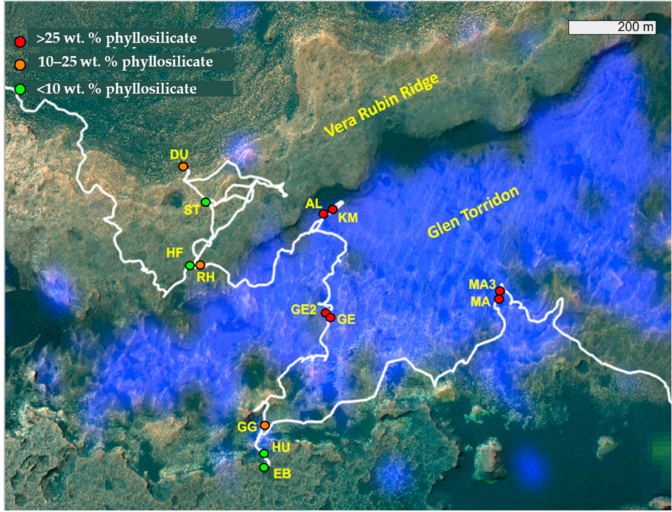
Figure 4. Compact Reconnaissance Imaging Spectrometer for Mars (CRISM) map of Fe/Mg–smectite spectral absorptions detections from orbit in the Glen Torridon region of Gale crater with the darkest blue representing the deepest spectral absorptions attributed to phyllosilicate (map courtesy Valerie Fox), and with drill holes reflecting CheMin phyllosilicate abundances. Red circles, phyllosilicate abundances greater than 25 wt. %. Orange circles, phyllosilicate abundances 10–25 wt. %. Green circles, represent phyllosilicate abundances <10 wt.